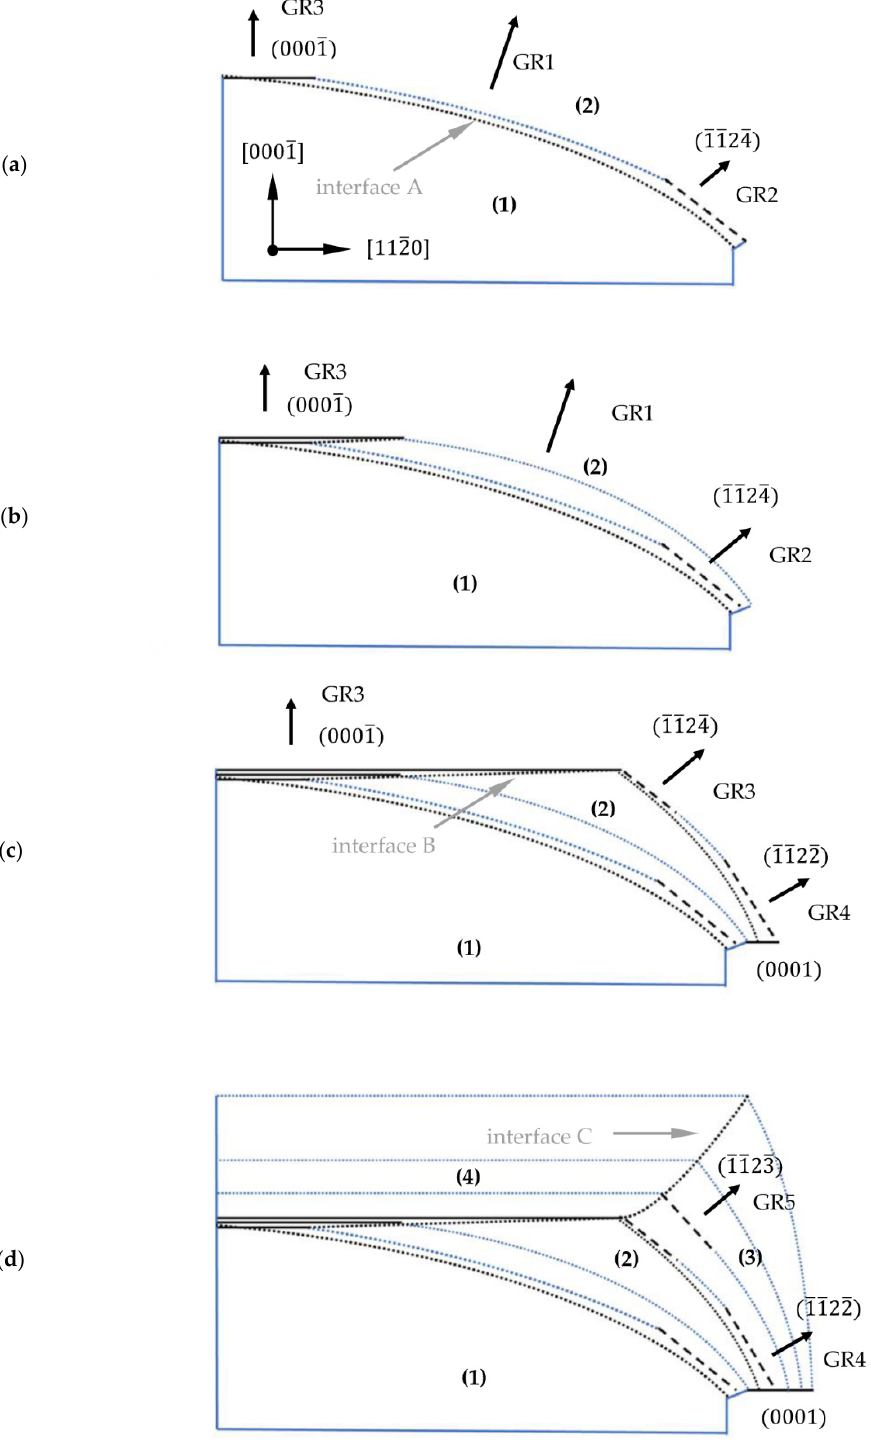
(cid:2) (cid:2) (cid:3) (cid:3) Figure 12. Model of Am-GaN growth on a lenticular seed along the 0001 and 1120 directions (cid:0) (cid:1) (cid:0) (cid:1) Figure 12. Model of Am-GaN growth on a lenticular seed along the [0001(cid:3364)] and [1(cid:3364)1(cid:3364)20] directions with a view of the 1100 plane: ( a ) the first stage of the growth—recovery of the 0001 plane and with a view of the (1(cid:3364)100) plane: ( a ) the first stage of the growth—recovery of the (0001(cid:3364)) plane (cid:0) (cid:1) (cid:0) (cid:1) formation of the semi-polar 1124 plane; ( b ) growth on the recovered 000 1 plane and growth on and formation of the semi-polar (1(cid:3364)1(cid:3364)24(cid:3364)) plane; ( b ) growth on the recovered (0001(cid:3364)) plane and (cid:0) (cid:1) (cid:0) (cid:1) (cid:0) (cid:1) (cid:0) (cid:1) the 1124 plane; ( c ) growth on the 0001 and 1124 planes with a transition between the 1124 growth on the (1(cid:3364)1(cid:3364)24(cid:3364)) plane; ( c ) growth on the (0001(cid:3364)) and (1(cid:3364)1(cid:3364)24(cid:3364)) planes with a transition be- (cid:0) (cid:1) (cid:0) (cid:1) and 1122 semi-polar planes and the formation of the ( 0001 ) plane; ( d ) growth on the 0001 and tween the (1(cid:3364)1(cid:3364)24(cid:3364)) and (1(cid:3364)1(cid:3364)22(cid:3364)) semi-polar planes and the formation of the (0001) plane; ( d ) (cid:0) (cid:1) (cid:0) (cid:1) (cid:0) (cid:1) 1122 planes with the transition between the 1124 and 1123 semi-polar planes and the expansion growth on the (0001(cid:3364)) and (1(cid:3364)1(cid:3364)22(cid:3364)) planes with the transition between the (1(cid:3364)1(cid:3364)24(cid:3364)) and (1(cid:3364)1(cid:3364)23(cid:3364)) of the ( 0001 ) semi-polar planes and the expansion of the (0001) plane.